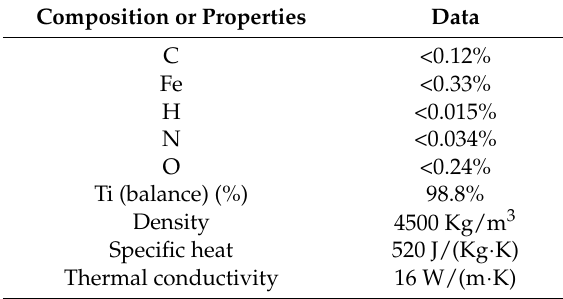
Table 1. Composition and properties (provided by: Maharaja Associates, Mumbai,